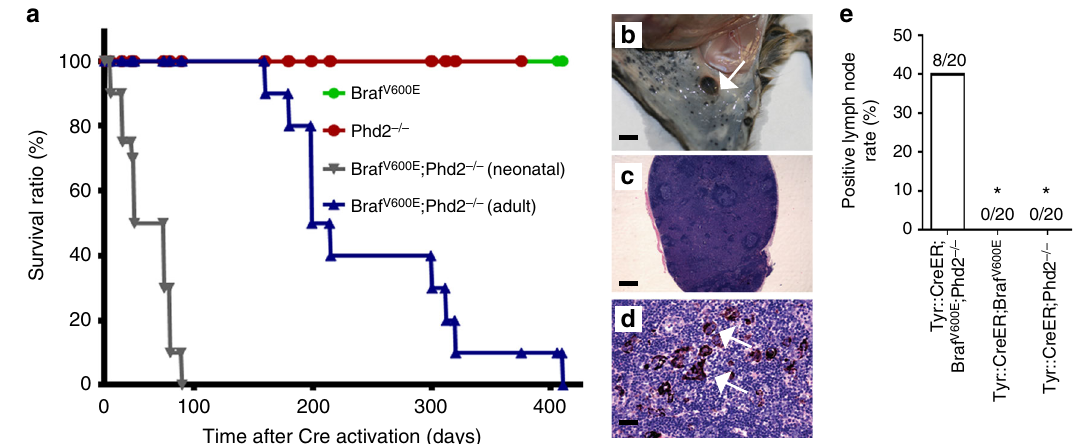
Fig. 3 Survival and lymph node metastasis in Tyr::CreER ; BRaf V600E ; Phd2 − / − mice. a Kaplan – Meier survival analysis of Tyr::CreER ; BRaf V600E ( n = 20), Tyr:: CreER ; Phd2 − / − ( n = 20), Tyr::CreER ; BRaf V600E ; Phd2 − / − postnatal mice ( n = 20) and Tyr::CreER ; BRaf V600E ; Phd2 − / − adult mice (6 weeks, n = 20) after 4- OHT induction. Log rank tests of survival plots of the data indicated a statistically signi fi cant difference between the following survival curves: Tyr::CreER ; BRaf V600E ; versus Tyr::CreER ; BRaf V600E ; Phd2 − / − mice ( p < 0.0001), and Tyr::CreER ; BRaf V600E ; Phd2 − / − adult versus Tyr::CreER ; BRaf V600E ; Phd2 − / − postnatal mice ( p < 0.0001). b – d Lymph node metastasis in Tyr::CreER ; BRaf V600E ; Phd2 − / − mice. A positive lymph node was present near the area with melanoma induction (arrow points to the lymph node, b ). The lymph node was enlarged with pigmented cells ( c ) and high-power view showed melanoma cells in the lymph node (arrows point to the tumor cells, d ). e Percentage of mice that developed lymph node metastasis. Bar in c indicates 200 μ m. Bar in d indicates 50 μ m. Bar in b indicates 3 mm. * p < 0.05 compared to Tyr::CreER;Braf V600E ;Phd2 − / − group using one-way ANOVA with pairwise